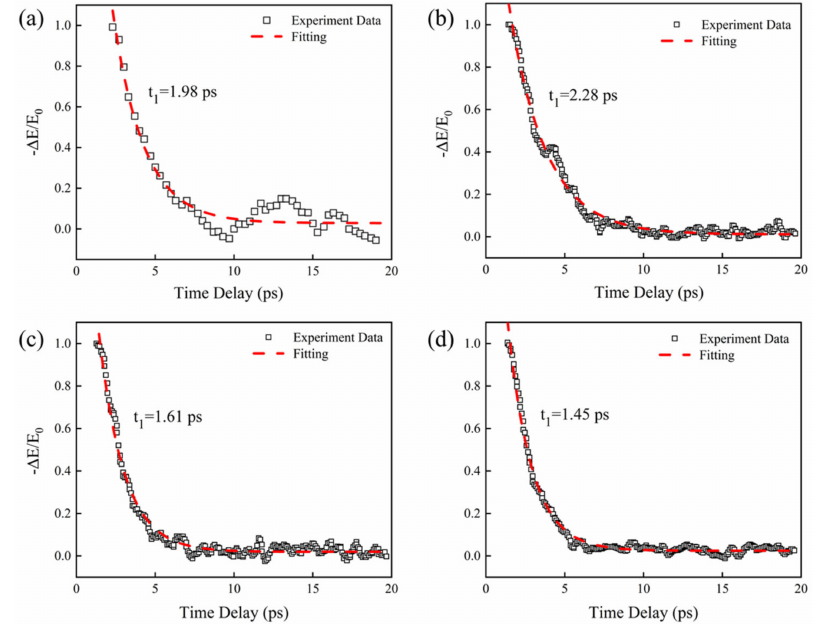
Figure 2. Normalized terahertz transmission change ( − ∆ E / E 0 ) induced by the pump power